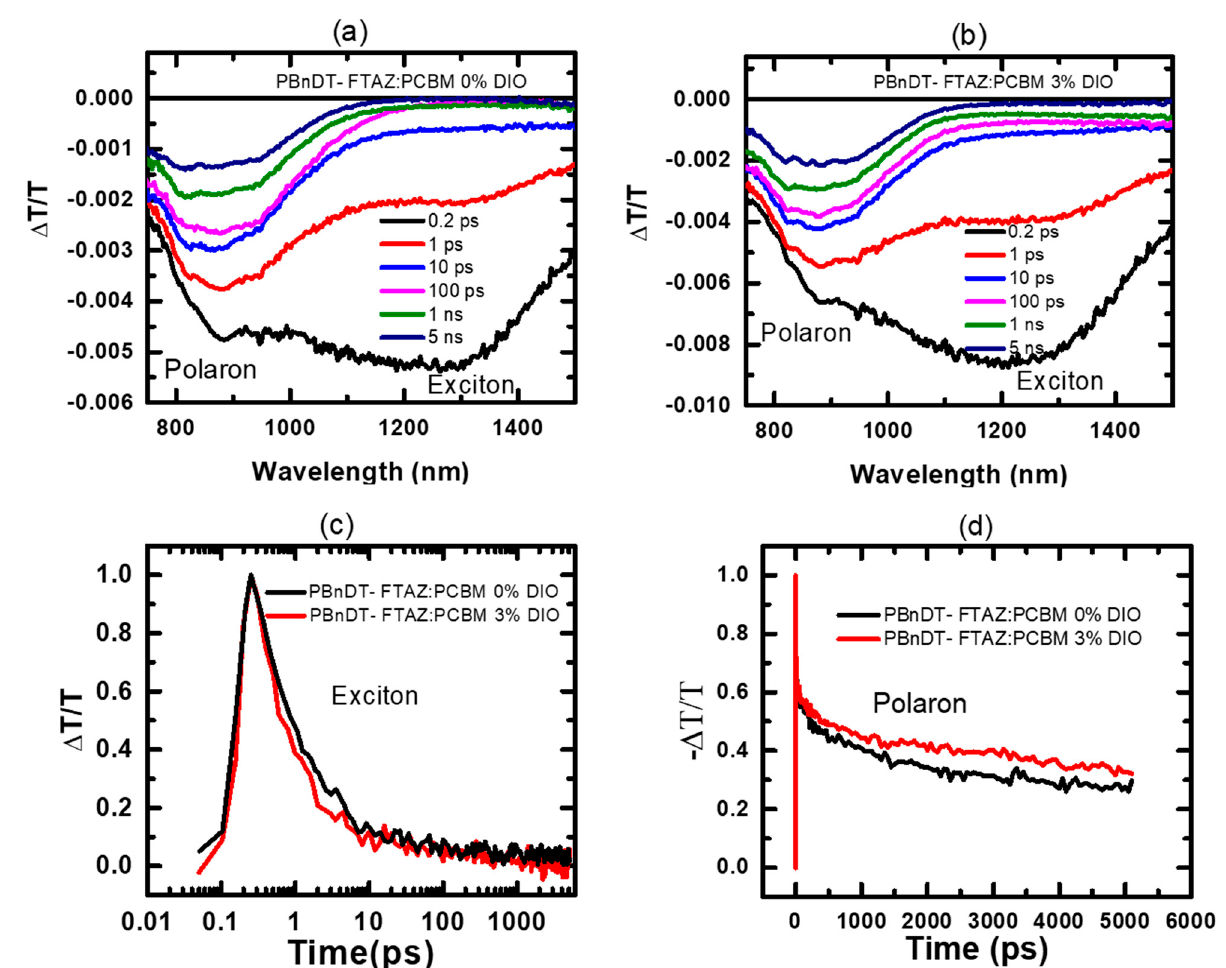
Figure 3. Transient absorption spectra of PBnDT-FTAZ:PCBM blend films with ( a ) 0% DIO and ( b ) 3% DIO, and comparation of ( c ) exciton and ( d ) charge separation dynamics.